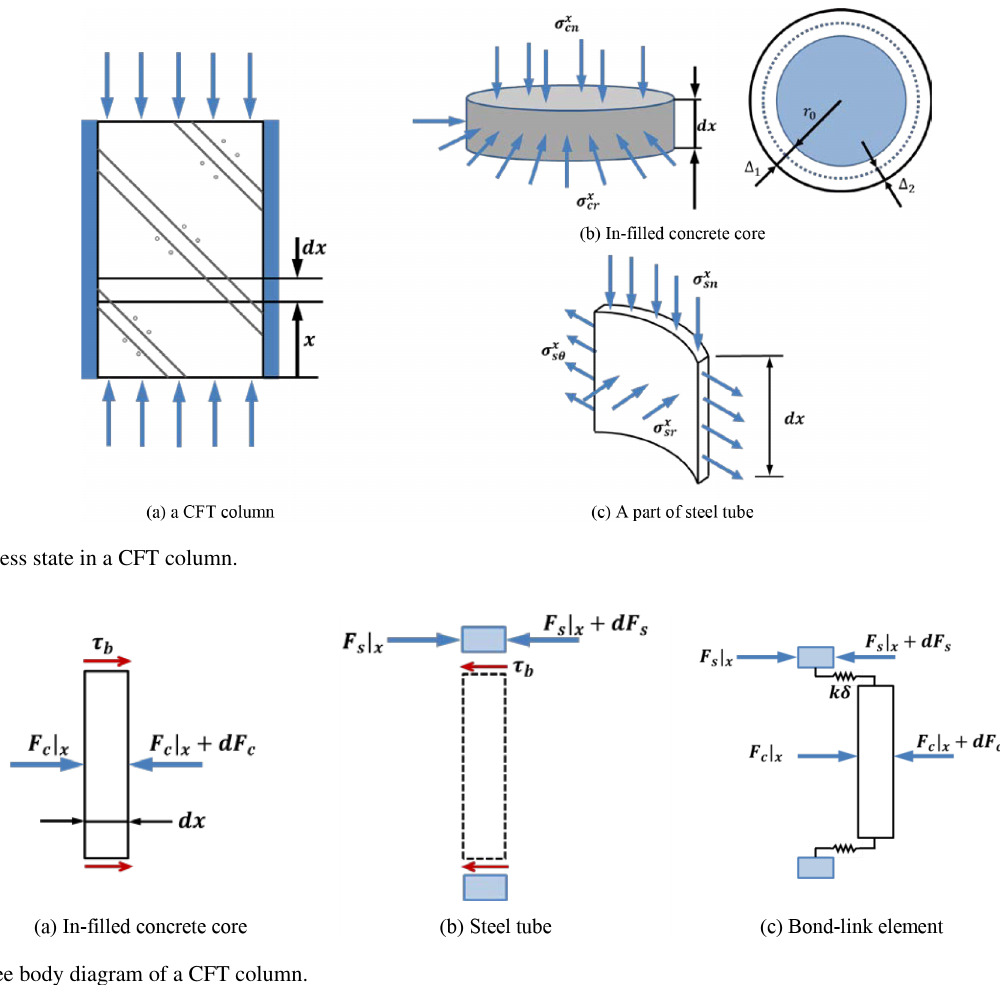
Figure 4. Free body diagram of a CFT column.